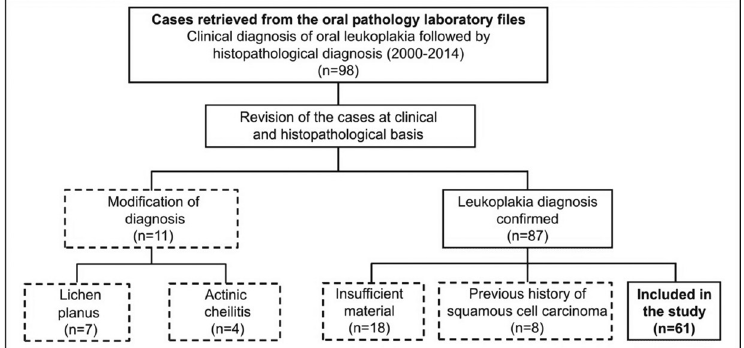
Figure 1- Flowchart of sampling strategy, depicting the criteria to select the study sample. After revision, the cases in which oral leukoplakia was confirmed were subjected to a strict evaluation to define if the amount of tissue was enough to prepare the required number of histological sections. Cases with previous history of squamous cell carcinoma were